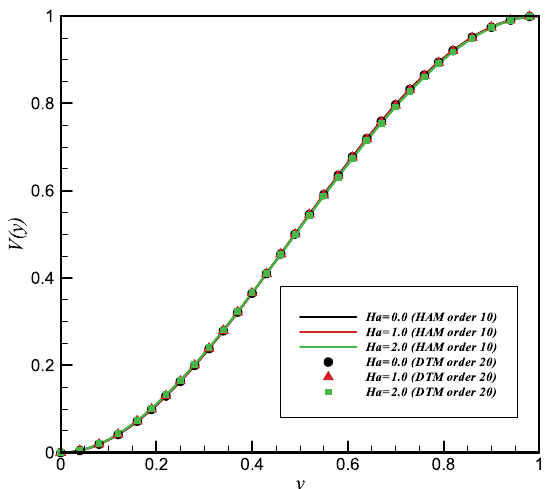
Fig. 14. The profile U ( y ) obtained by the 10th-order approximation of the HAM and 20th-order approximation of the DTM for different values of Ha, when Re = 1 . 0 ,